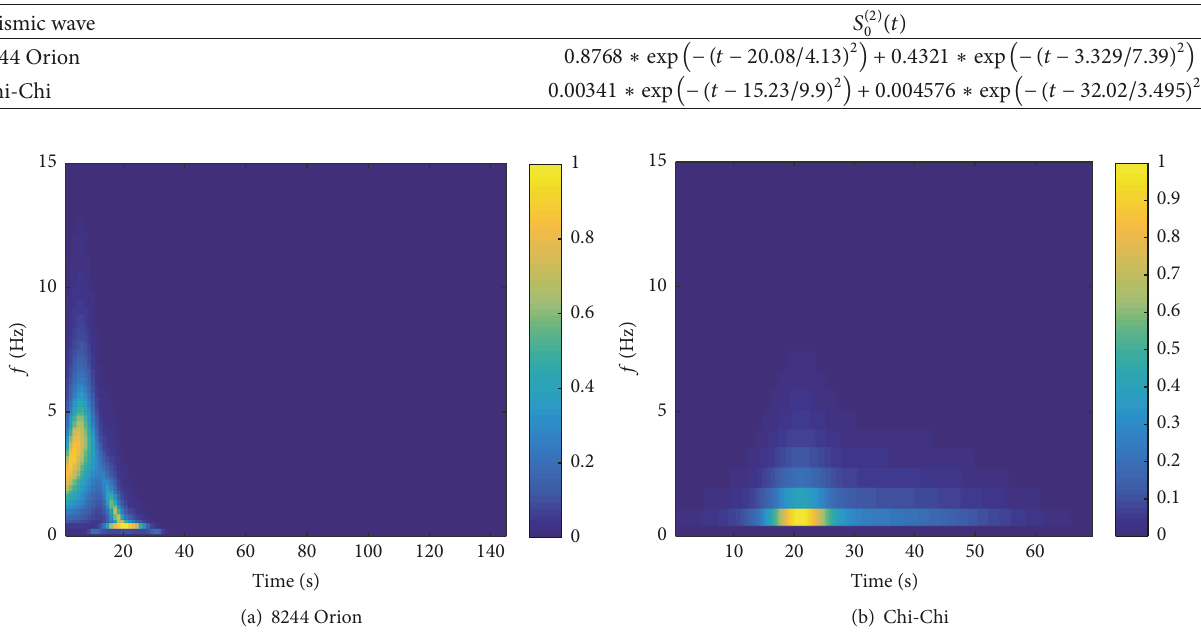
Table 2: Fitted time-varying expressions for 𝑆 (2) 0 (𝑡) .